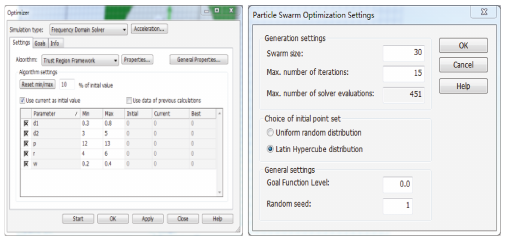
Figure 3: Optimization of the cell in the CST Microwave Studio.